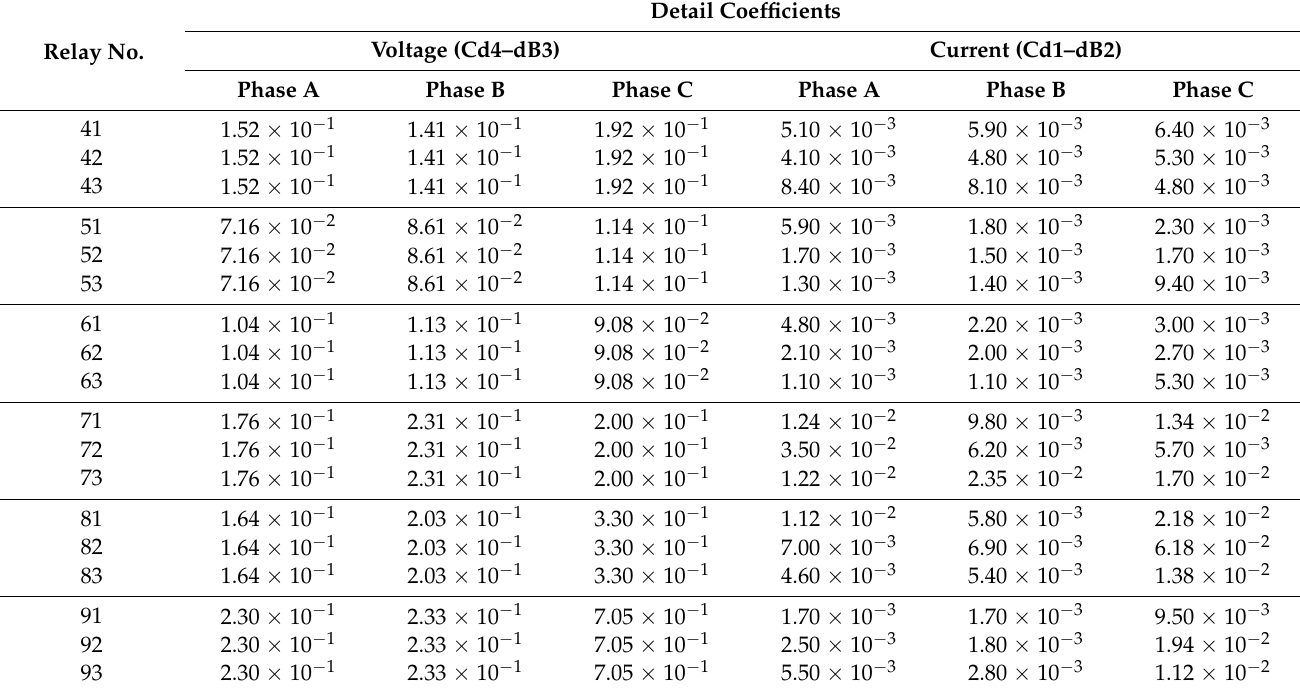
Table 4. Detail coefficients during phase-to-ground arc fault at transmission line from bus 8 to bus 9.